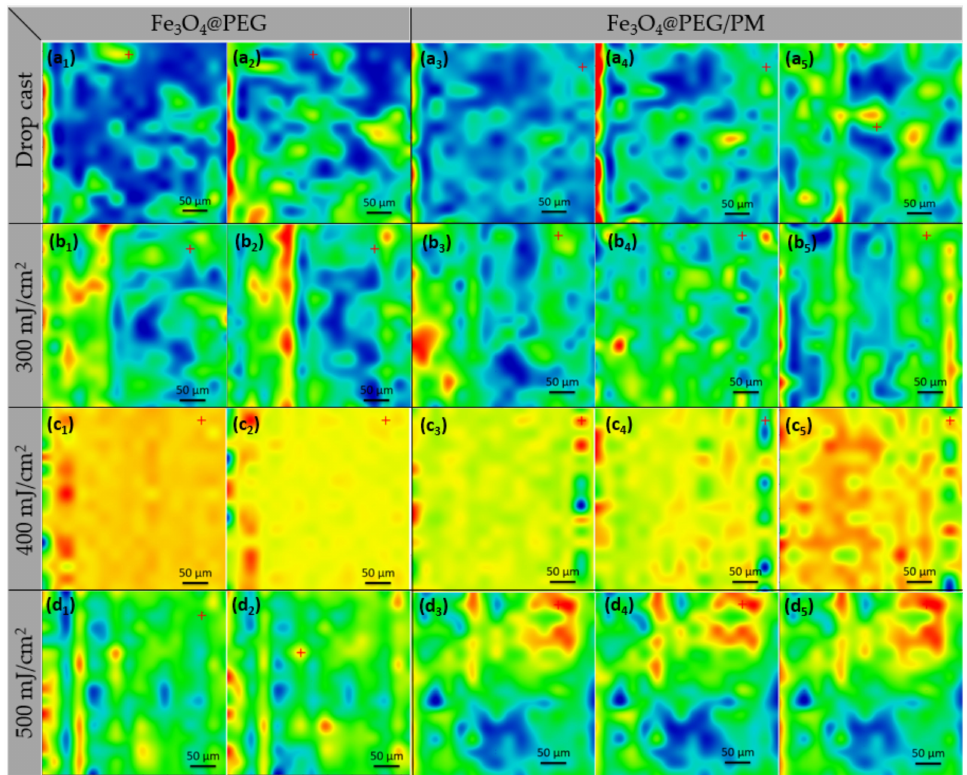
Figure 6. IR maps of Fe 3 O 4 @PEG (1,2) and Fe 3 O 4 @PEG/PM (3,4,5); dropcast ( a ), F = 300 mJ/cm 2 ( b ), F = 400 mJ/cm 2 ( c ), F = 500 mJ/cm 2 ( d ), based on the distribution of C-H (1), C-O (2), C-H (3), C-O (4) and (C=O (5), assigned to PEG (1,2,3,4) and PM (5).